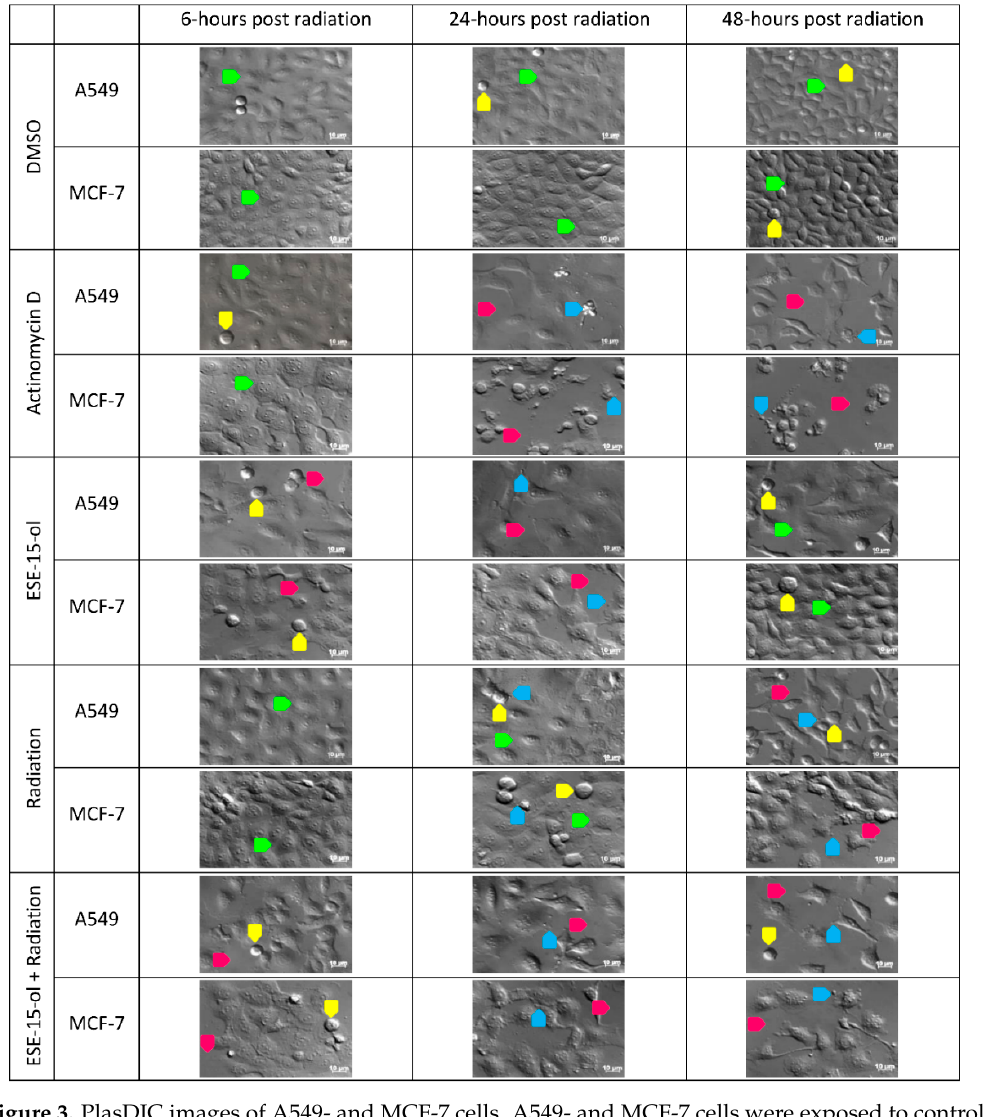
Figure 3. PlasDIC images of A549- and MCF-7 cells. A549- and MCF-7 cells were exposed to control and treatment conditions over a 48-h time period. Images illustrate cells in interphase (green arrow), metaphase (yellow arrow), apoptotic bodies (blue arrow), and decreased cell density (pink arrow). Scale bars represent 10 µm.